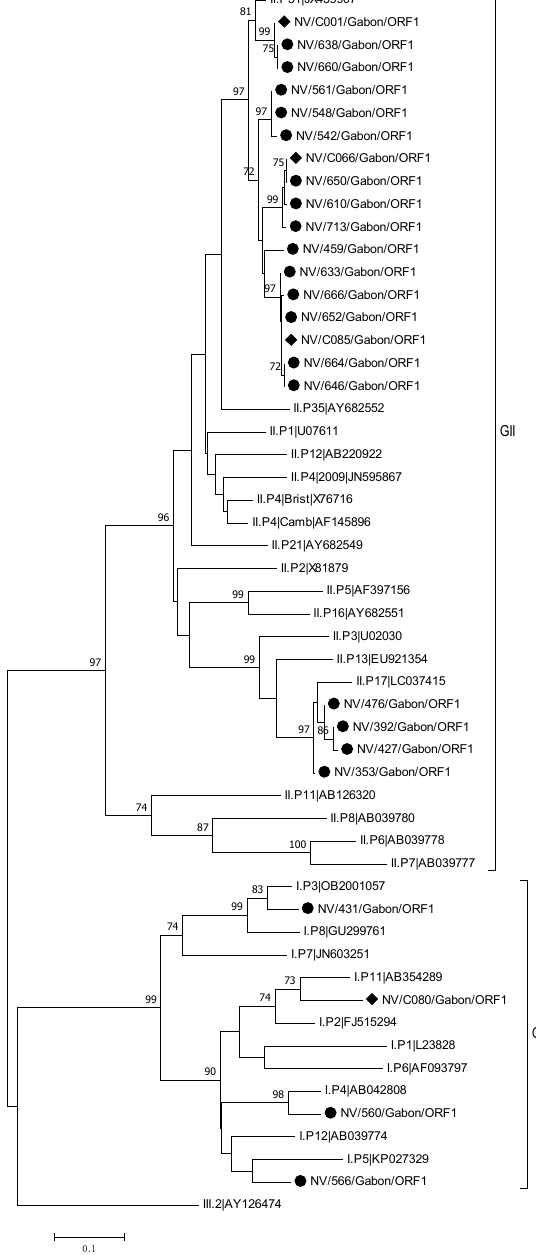
Figure 2. Phylogenetic tree of a 248 bp alignment of ORF1 region of the GI and GII NoV strains from Gabon and NoV reference sequences (accession nos. are indicated). Samples from symptomatic patients are marked with a dot and samples from asymptomatic with a rhombus. The tree was constructed using the neighbor-joining method with bootstrap test (1000 replicates) and the Kimura 2-parameter method available in MEGA7. Bootstrap values above 70 are shown. The bar indicates the nucleotide substitution per site.